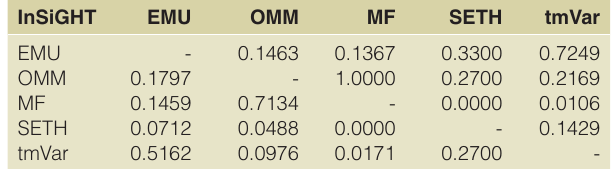
Table 13. Overlap of mutations extracted by each tool on the InSiGHT database from all article data sources. The tools are Extractor of Mutations (EMU), OpenMutationMiner (OMM), MutationFinder (MF), tmVar and SNP Extraction Tool for Human Variations (SETH).